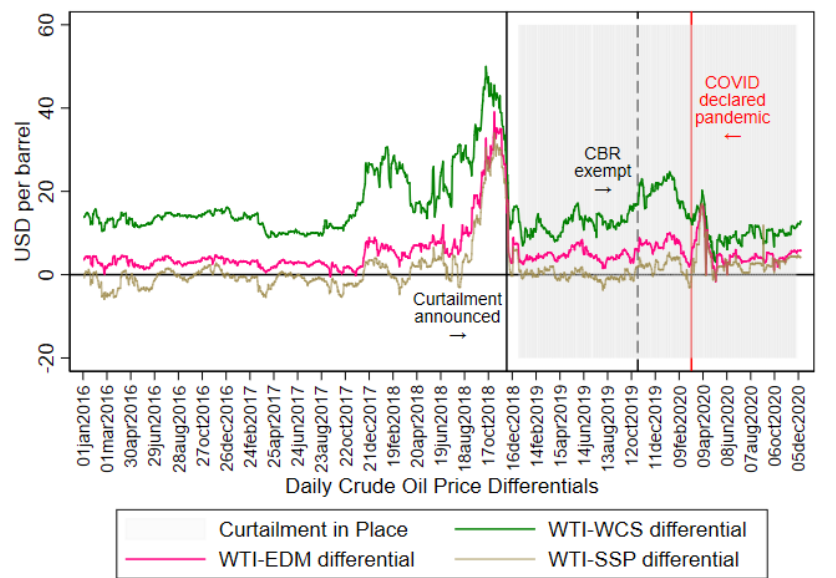
Figure 4. Daily Oil Price Differentials, 2016–2020 [8,9]. Western Canadian Select (WCS) is a key benchmark for Alberta heavy oil production, Edmonton Light Sweet (EDM) is a benchmark for Alberta light oil production, and Syncrude Synthetic Sweet (SSP) is a benchmark for Alberta synthetic crude oil (derived from the oil sands). “CBR” is crude by rail, which became exempt from curtailment on 28 October 2019. See Figure 2 for full